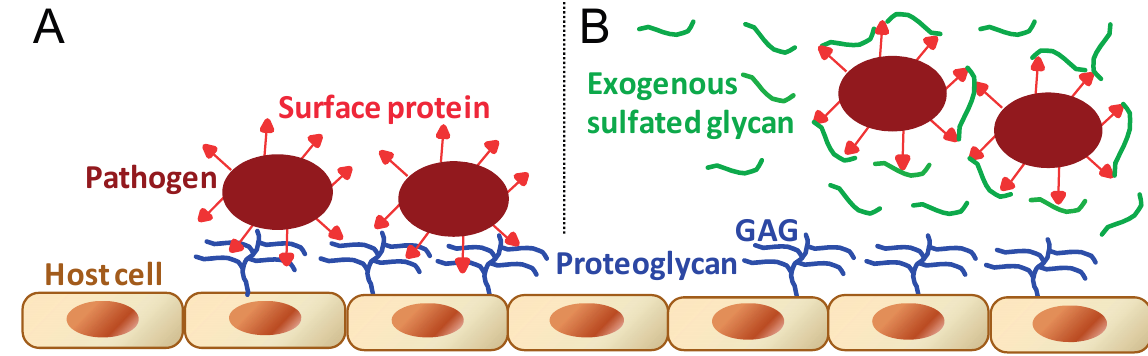
Figure 5. General schematic representation for the molecular mechanisms during ( A ) the microbial infection of pathogens such as bacteria, virus, fungus, and protozoan parasites; and during ( B ) the administration at certain concentrations of exogenous sulfated glycans endowed with antimicrobial activity. In ( A ), microbial infection is driven by molecular interactions between pathogen proteins and host cell GAGs. In ( B ), the antimicrobial sulfated glycan competes with host cell GAGs by binding to proteins displayed at the microbial surface, impairing or disrupting then the pathogen attachment onto host